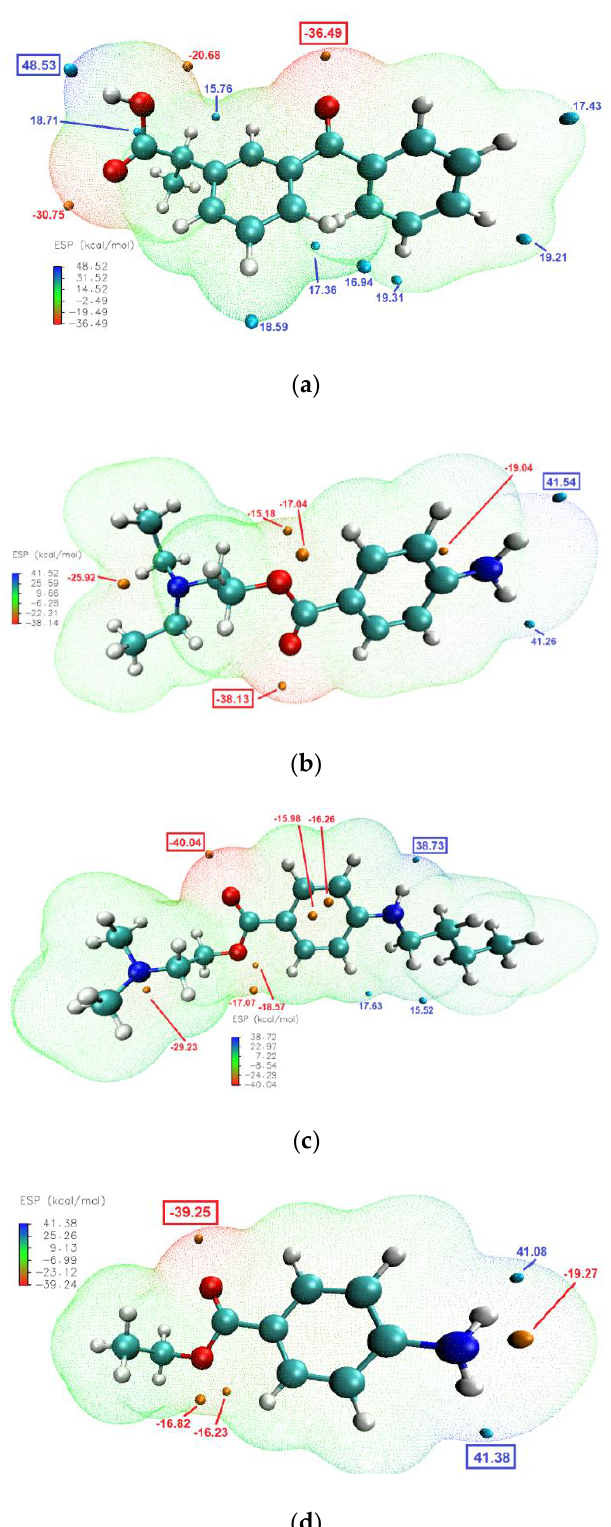
Figure 8. Electrostatic potential of: ( a ) KET, ( b ) PRO, ( c ) TET and ( d ) BEN mapped on the 0.001 au contours of the electron density of the molecules optimized by DFT. The negative regions are indicated in blue, while the positive regions are shown in red. Surface local minima and maxima (only values > 15 kcal/mol) are represented as orange and cyan points, respectively. The global maximum and minimum for every molecule are shown in boxes in large font. The unit is kcal/mol.